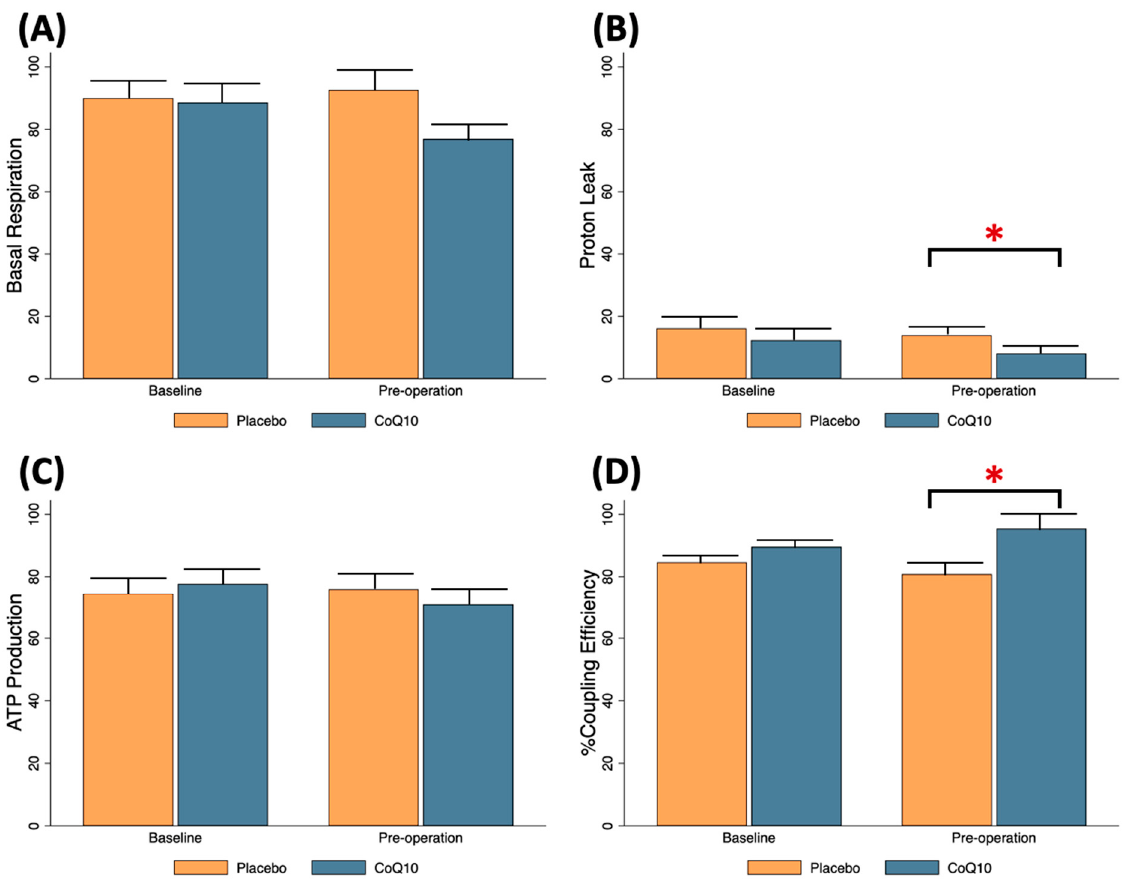
Figure 3. Mitochondrial respiration alteration following 2-week preoperative CoQ10 supplementa- tion. ( A ) basal respiration, ( B ) proton leak, ( C ) ATP production, ( D ) % coupling efficiency. * p < 0.05 between CoQ10 and placebo groups.